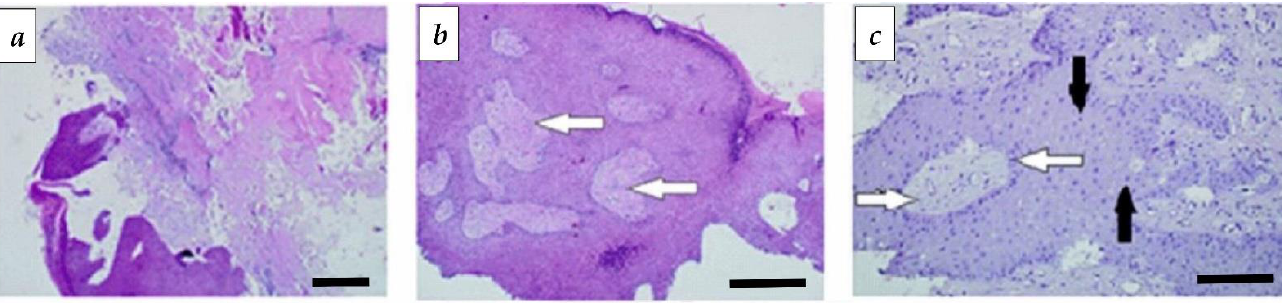
Figure 7. Histology of the edge of the decubital ulcer of the patient of the main group on the 1st ( a ), 14th ( b ), and 28th ( c ) day of treatment. White arrows show pronounced regenerative changes in the integumentary stratified squamous epithelium with acanthosis and increased capillary neoangio- genesis. Black arrows indicate maturing granulation tissue, replacing the foci of fibrinoid–necrotic changes with mature connective tissue. The scale bar is 100 µm.